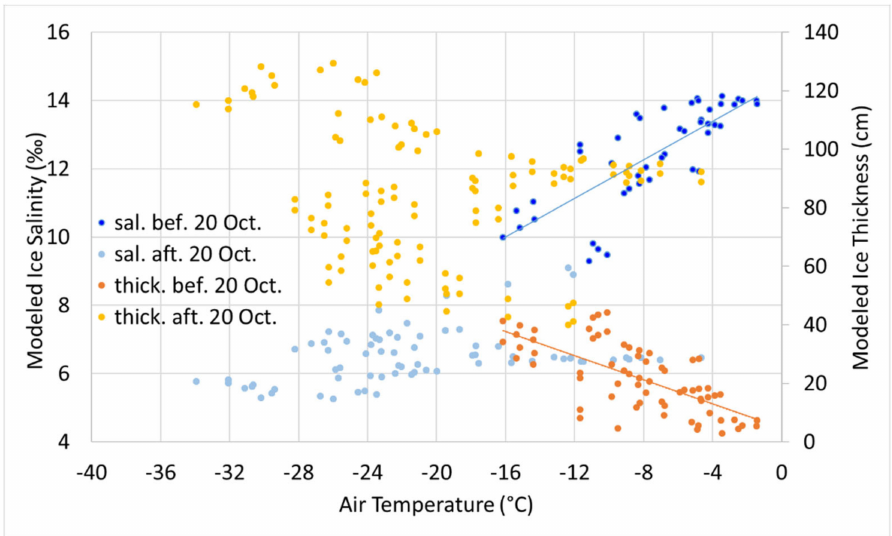
Figure 3. Modeled bulk salinity and ice thickness variation with air temperature before and after 20 October 2017. This date marks the ice thickness of 40 cm. Data are obtained from RB and